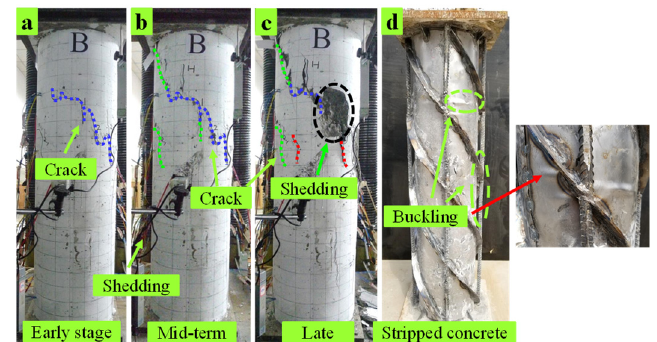
Figure 8. Damage phenomenon of C5. ( a ) Early-stage ( b ) Mid term ( c ) Late. ( d ) Stripped concrete